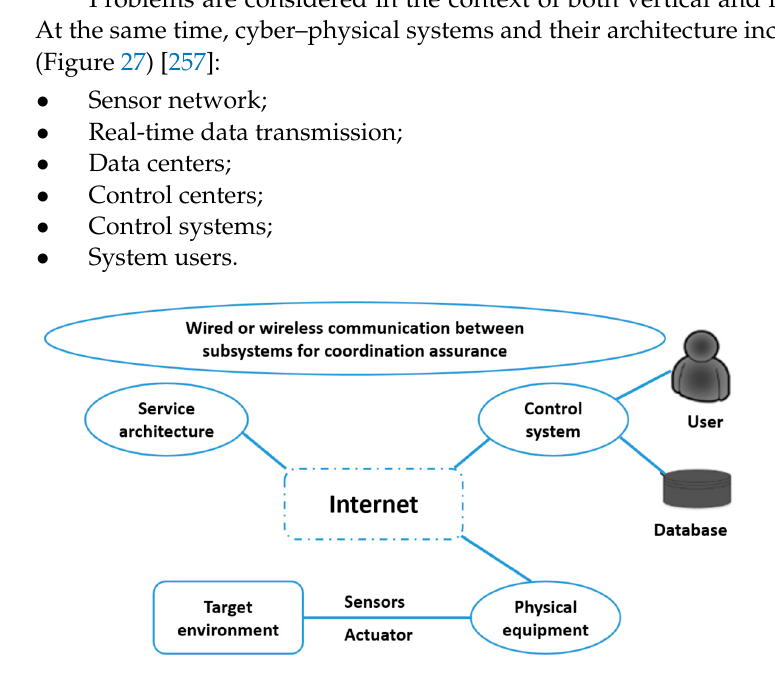
Figure 27. Service-oriented CPS architecture.